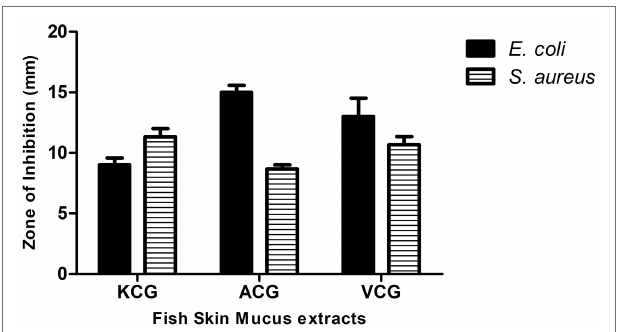
FIGURE 2 | Graph showing Zone of Inhibition of Clarias gariepinus mucus extracts from different lakes. VCG-Lake Victoria’s C. gariepinus ACG-Lake Albert’s C. gariepinus KCG-Lake Kyoga’s C. gariepinus. Lake Albert’s C. gariepinus skin mucus extracts have the highest Zone of Inhibition (15.00 ± 0.58 mm) on E. coli . The highest Zone of Inhibition on Staphylococcus aureus was registered on Lake Kyoga’s fish skin mucus extracts (Zone of Inhibition: 11.67 ± 0.67 mm). The image was rendered in GraphPad 5.0 statistical